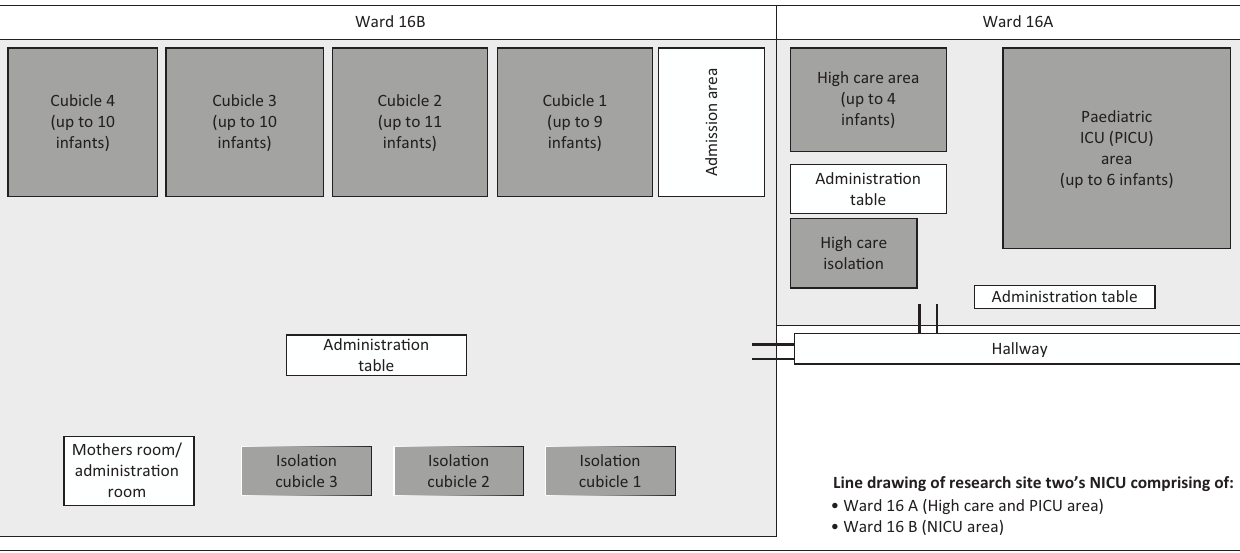
FIGURE 2: Layout of site